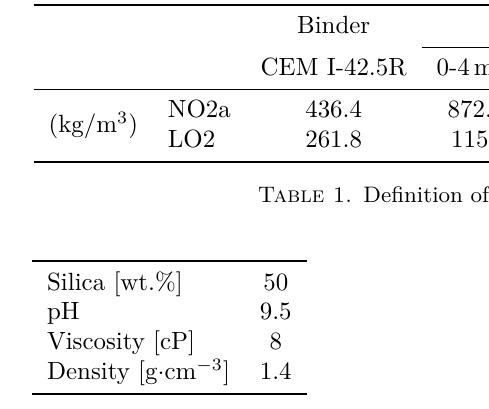
Table 2. Typical properties of Levasil CB8 [5].